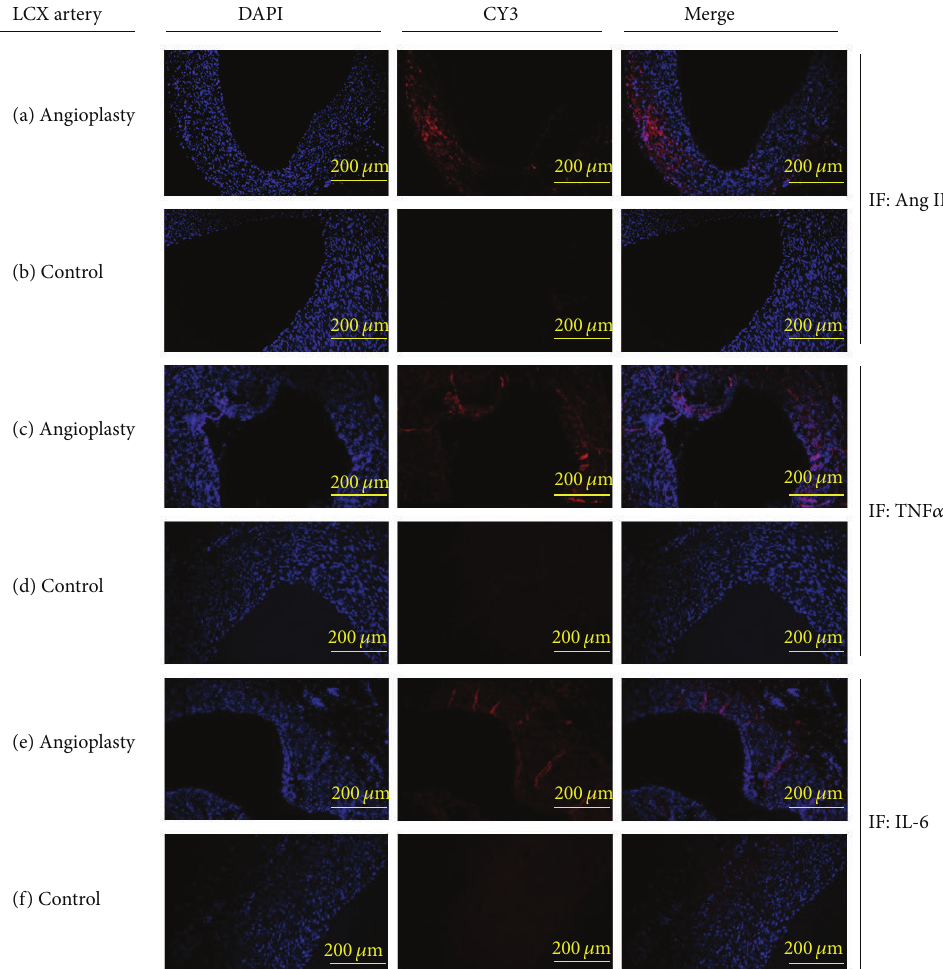
Figure 2: Angioplasty increases the local production of atherogenic cytokines: histological evaluation was performed on LCX arteries taken from hypercholesterolemic microswine at 4 months after angioplasty and age-matched control hypercholesterolemic microswine. The immunostaining was assessed for Ang II ((a)-(b)), TNF 𝛼 ((c)-(d)), and IL-6 ((e)-(f)). Each image shown is representative of independent experiments performed from separate microswine ( 𝑛 = 3